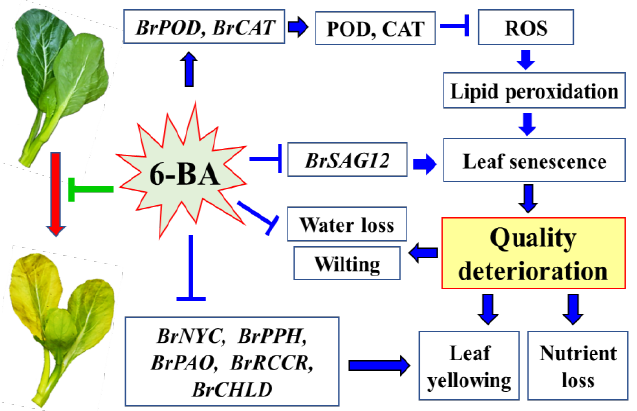
Figure 5. A proposed model of mechanism underlying postharvest 6-BA treatment maintains postharvest Chinese flowering cabbage